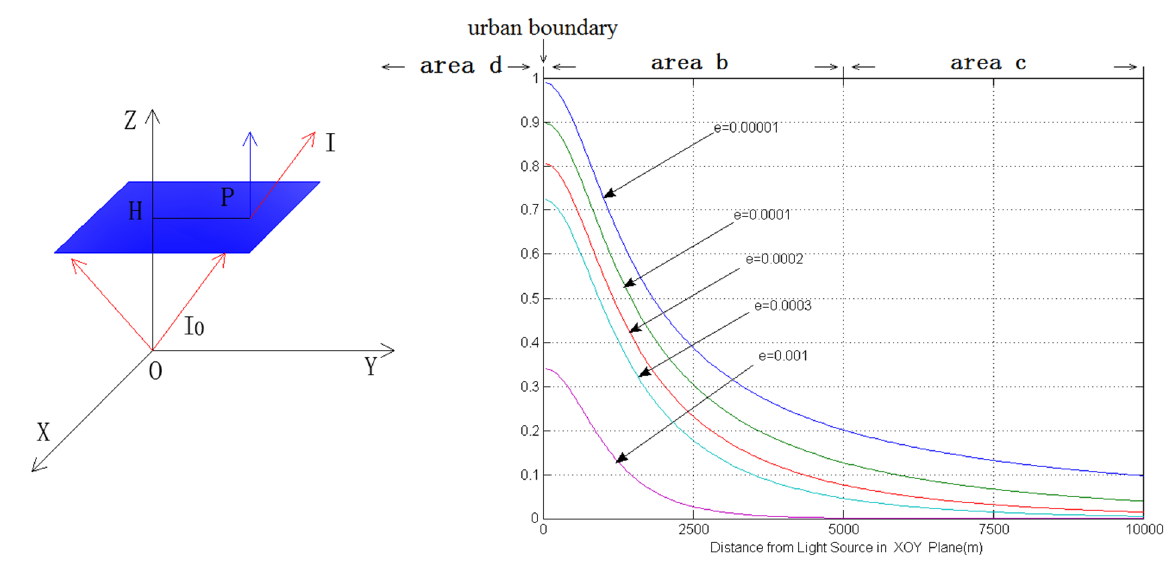
Figure 6. The sketch map ( left ) describes the position of a point light source and the surface to compute the luminous flux. Point O has a point light source with a light intensity of 1.0 unit (I 0 ). The distance from point O to point H is 1076 meters (The aerosol scale height of Beijing in winter is 1076 meters [57]). A horizontal plane passes through point H and is perpendicular to the Z-axis; this plane is termed the Z = 1076 m Plane. Point P is on the Z = 1076 m Plane. The luminous flux through point P and parallel to the Z-axis is a function of two parameters. One is the distance from point P to point H; the other is the extinction coefficient of atmosphere. The line chart ( right ) describes the function for a different situation. The X-axis is the distance from point P to point H, and the Y-axis is the upward luminous flux through point P and parallel to the Z-axis. The label e is the extinction coefficient of atmosphere. Area d was a light-emitting region, and areas b and c were not. The upward luminous flux of areas b and c was radiated from area